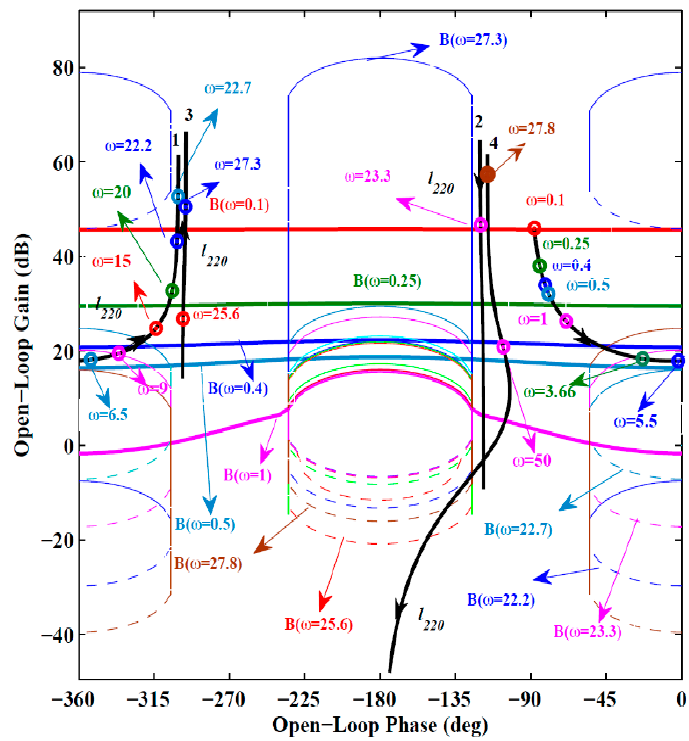
Figure 6. Channel-22 (upper magnet) nominal loop-shaping plot. Here, B ( ω ) denotes the bounds at each design frequency ω and the numbers denoted in bold (1,2,3,4) at the nominal loop transmission function path denotes the phase shift.